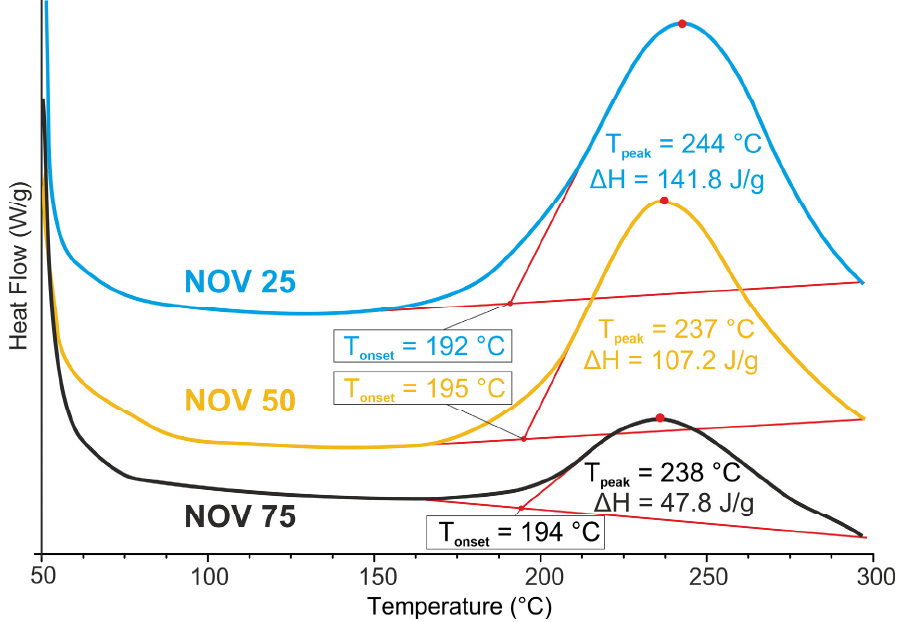
Figure 4. DSC of blends NOV 25, NOV 50, NOV 75.